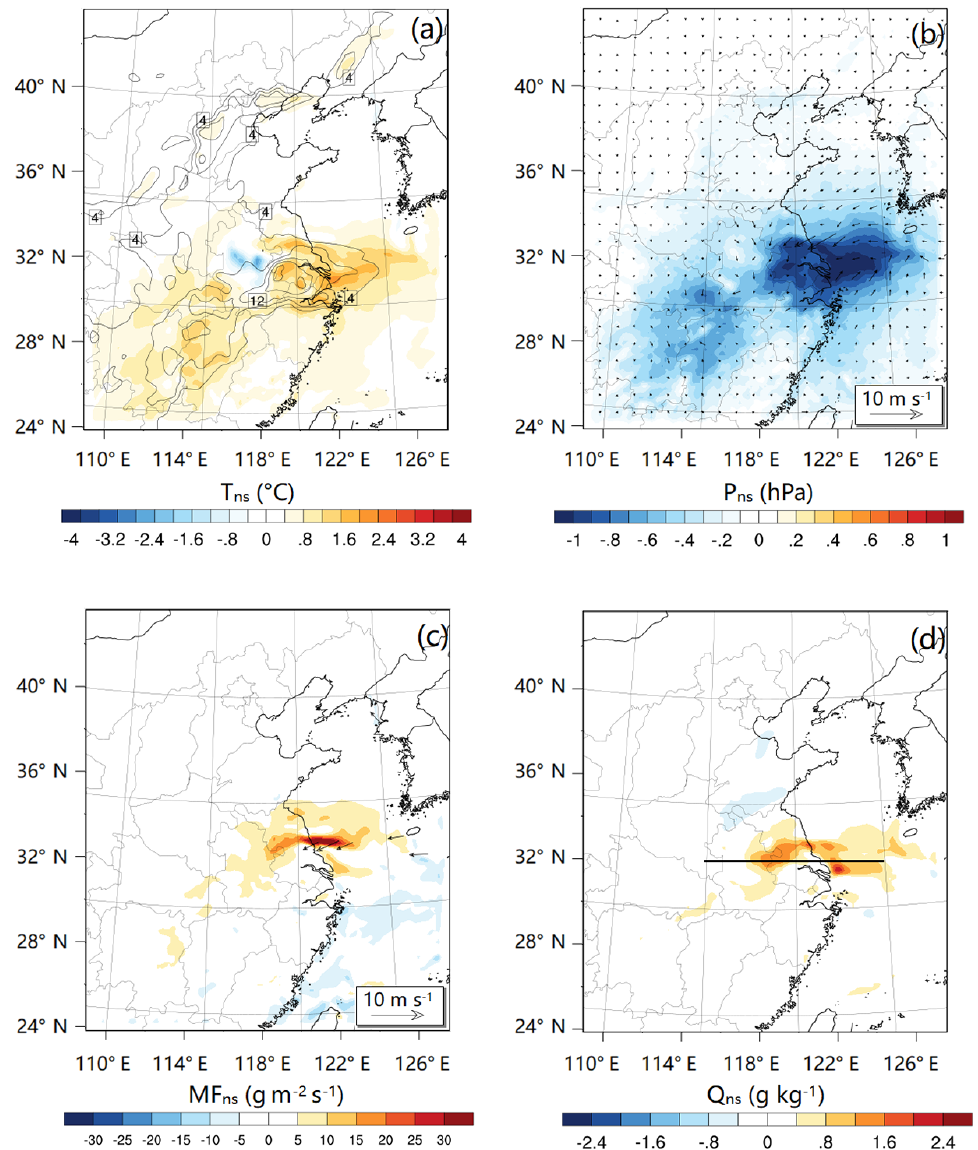
Figure 10. BC-introduced increase of air temperature (a) , low-pressure perturbation and cyclonic anomaly in wind field (b) , increase of moisture advection (c) and increase of water vapor mixing ratio (d) in the surface layer at 14:00LST on 6 December. Arrows shown in (c) are the BC-induced velocity change with magnitude larger than 3ms − 1 , which are used to represent the direction of the enhanced horizontal moisture flux. The line in (d) denotes the location where the cross section of BC-induced increase of temperature and moisture (as well as the PBLH in different experiments) is plotted in Fig. S5, and the rectangle denotes the offshore area in which the average profiles of potential temperature and water vapor mixing ratio in EXP_CTL and EXP_NOBC are calculated and plotted in Fig.